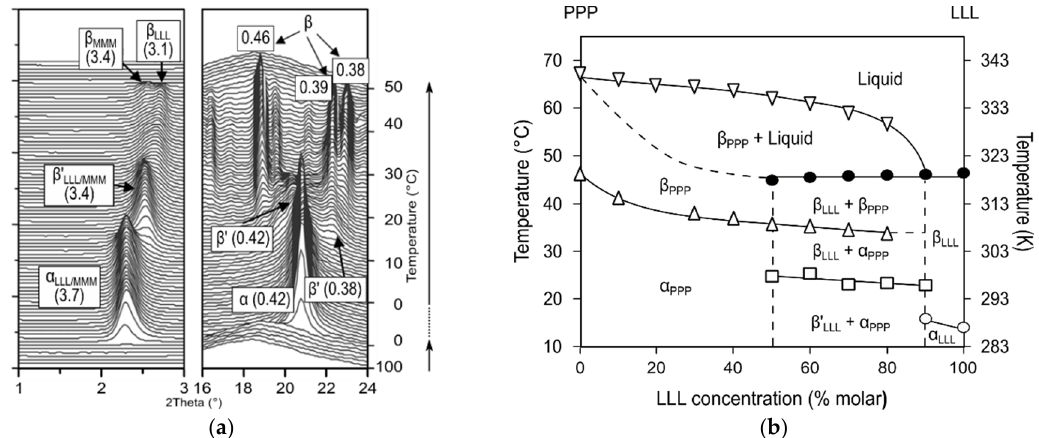
Figure 3. Mixing phase behavior of binary mixtures of monoacid tri-saturated TAGs. ( a ) Synchrotron source light X-ray diffraction (SR-XRD) patterns of a 70LLL/30MMM mixture during a thermal process of cooling and subsequent heating at 100 °C·min − 1 and 5 °C·min − 1 , respectively; and, ( b ) kinetic phase diagram of LLL/PPP mixtures. Adapted with permission from [70,82], © 2020 John Wiley & Sons, © 2003 American Chemical Society.